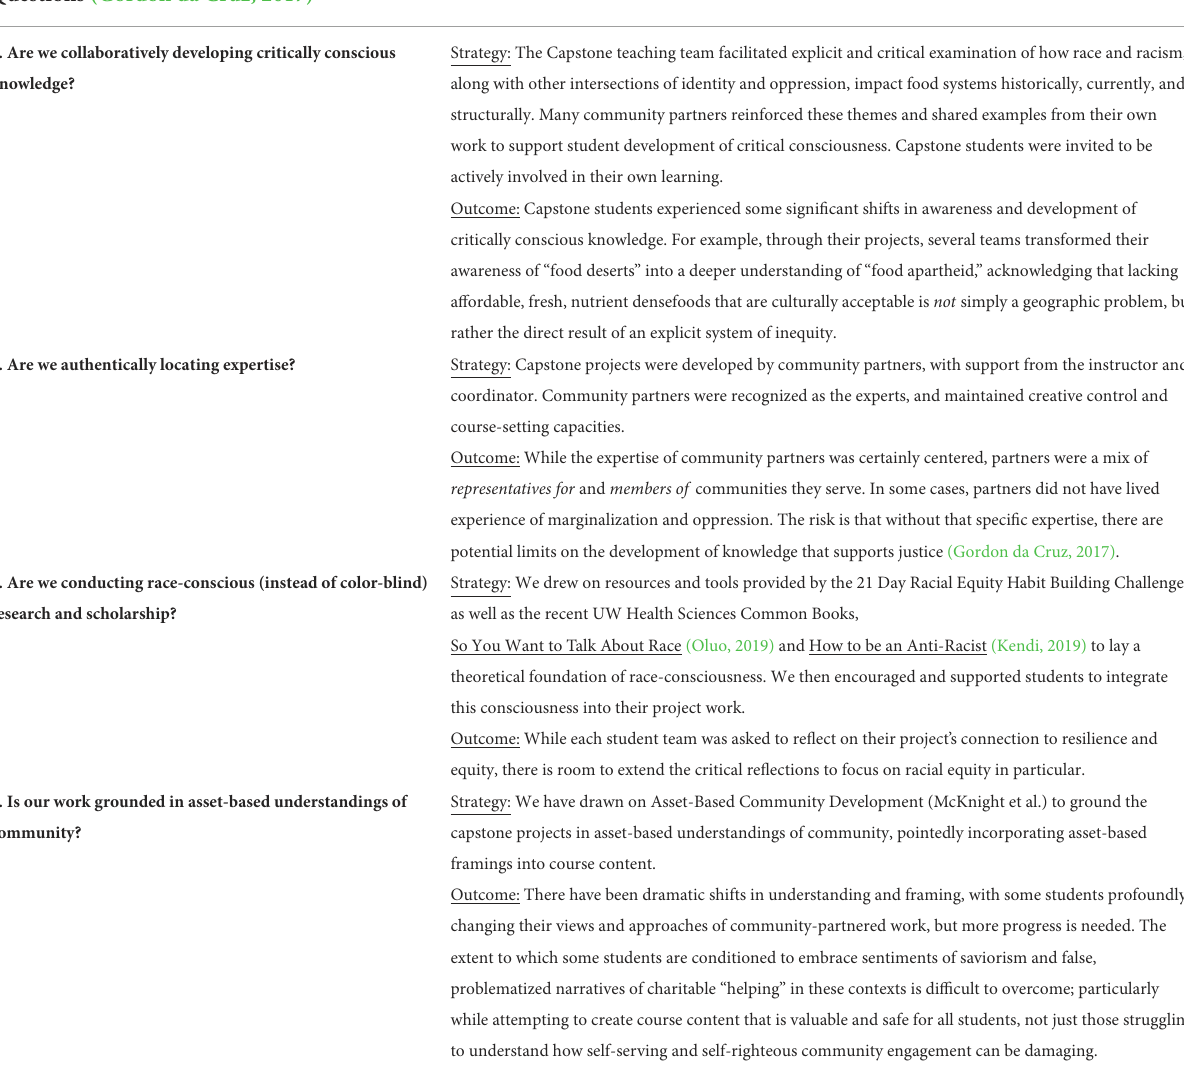
TABLE 2 Questions, strategies, and outcomes of critical community-engaged scholarship within the first 2 years of the UW Food Systems Capstone, 2020 and 2021. Critical Community-Engaged